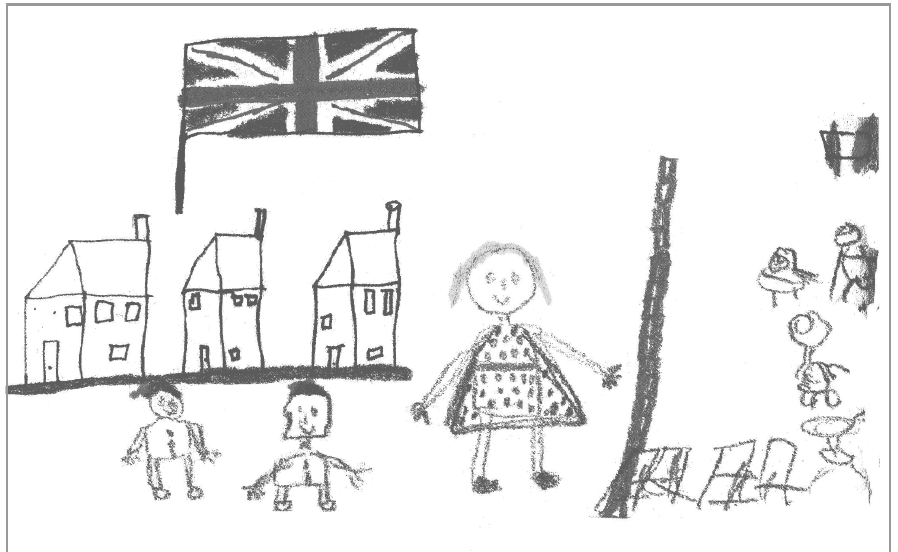
Figure 1: George’s drawing, showing the separation of the British and Irish realms in Belfast, North Ireland (Ulster); on the left the Protestant side with nice houses, nice children, a big British flag; on the right the Catholic side barely drawn shabby huts, little monsters, a carelessly drawn Irish flag without pole.